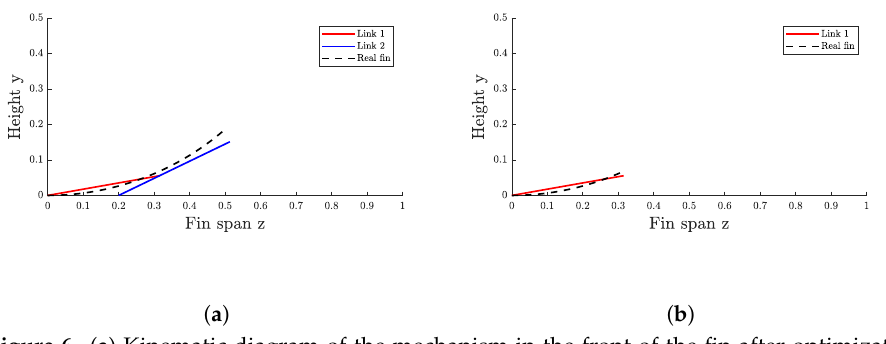
Figure 6. ( a ) Kinematic diagram of the mechanism in the front of the fin after optimization and ( b ) kinematic diagram of the mechanism in the front of the fin after optimization.